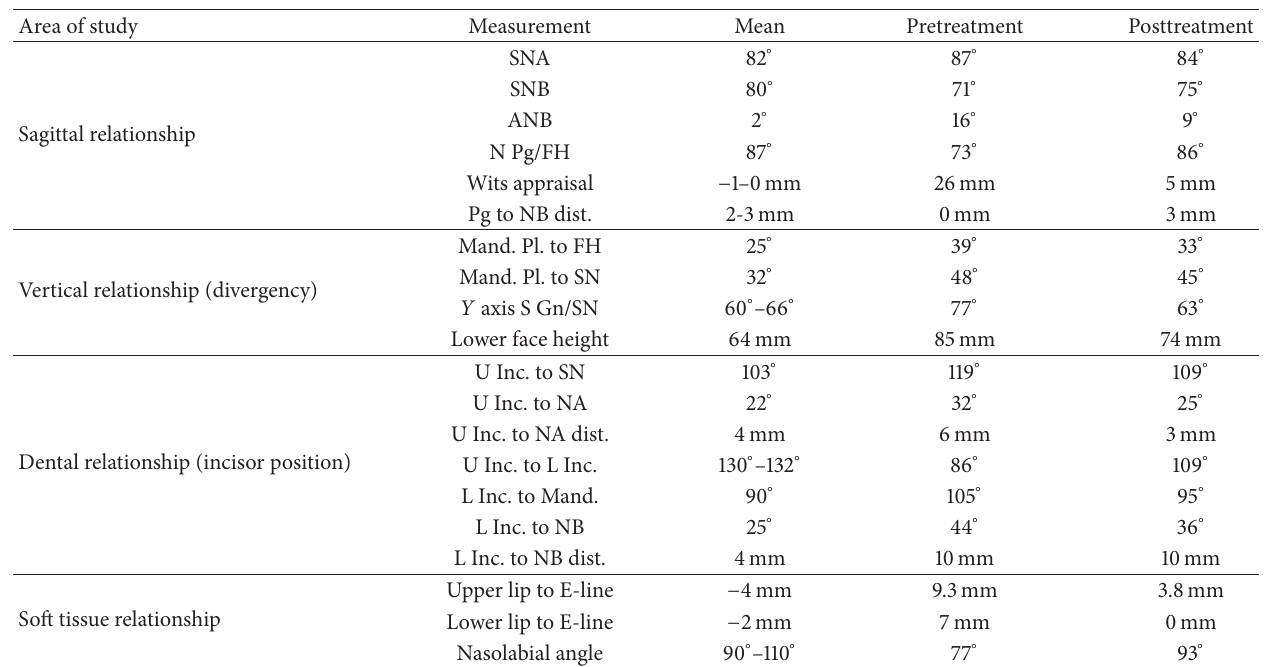
Figure 2: Presurgical intraoral photographs. Table 1: Cephalometric